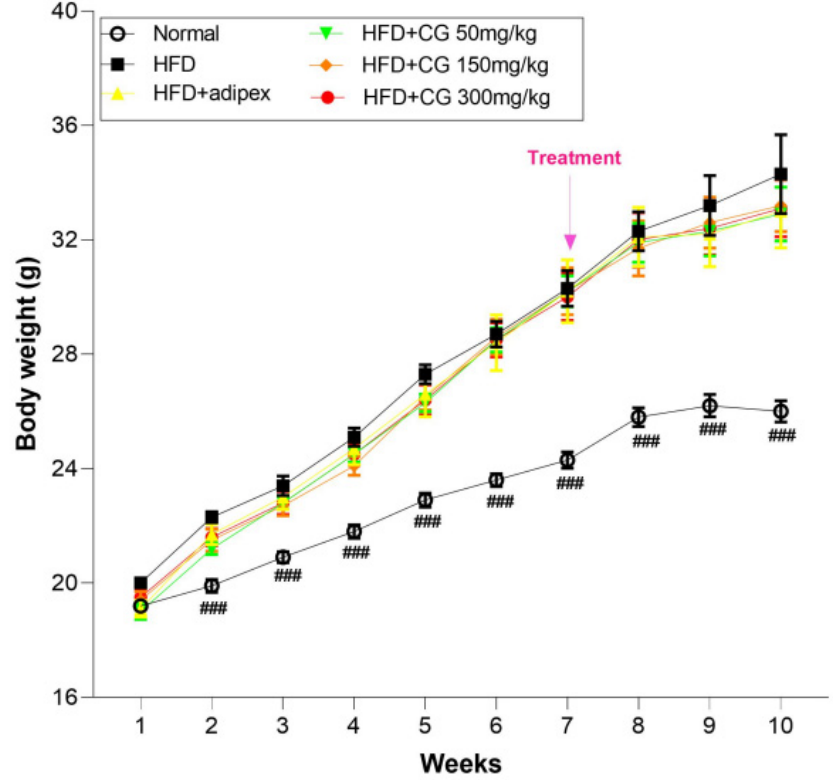
Figure 1. Effect of chitoglucan on body weight. Data represent means ± S.E.M. ### p < 0.001 compared with HFD group .